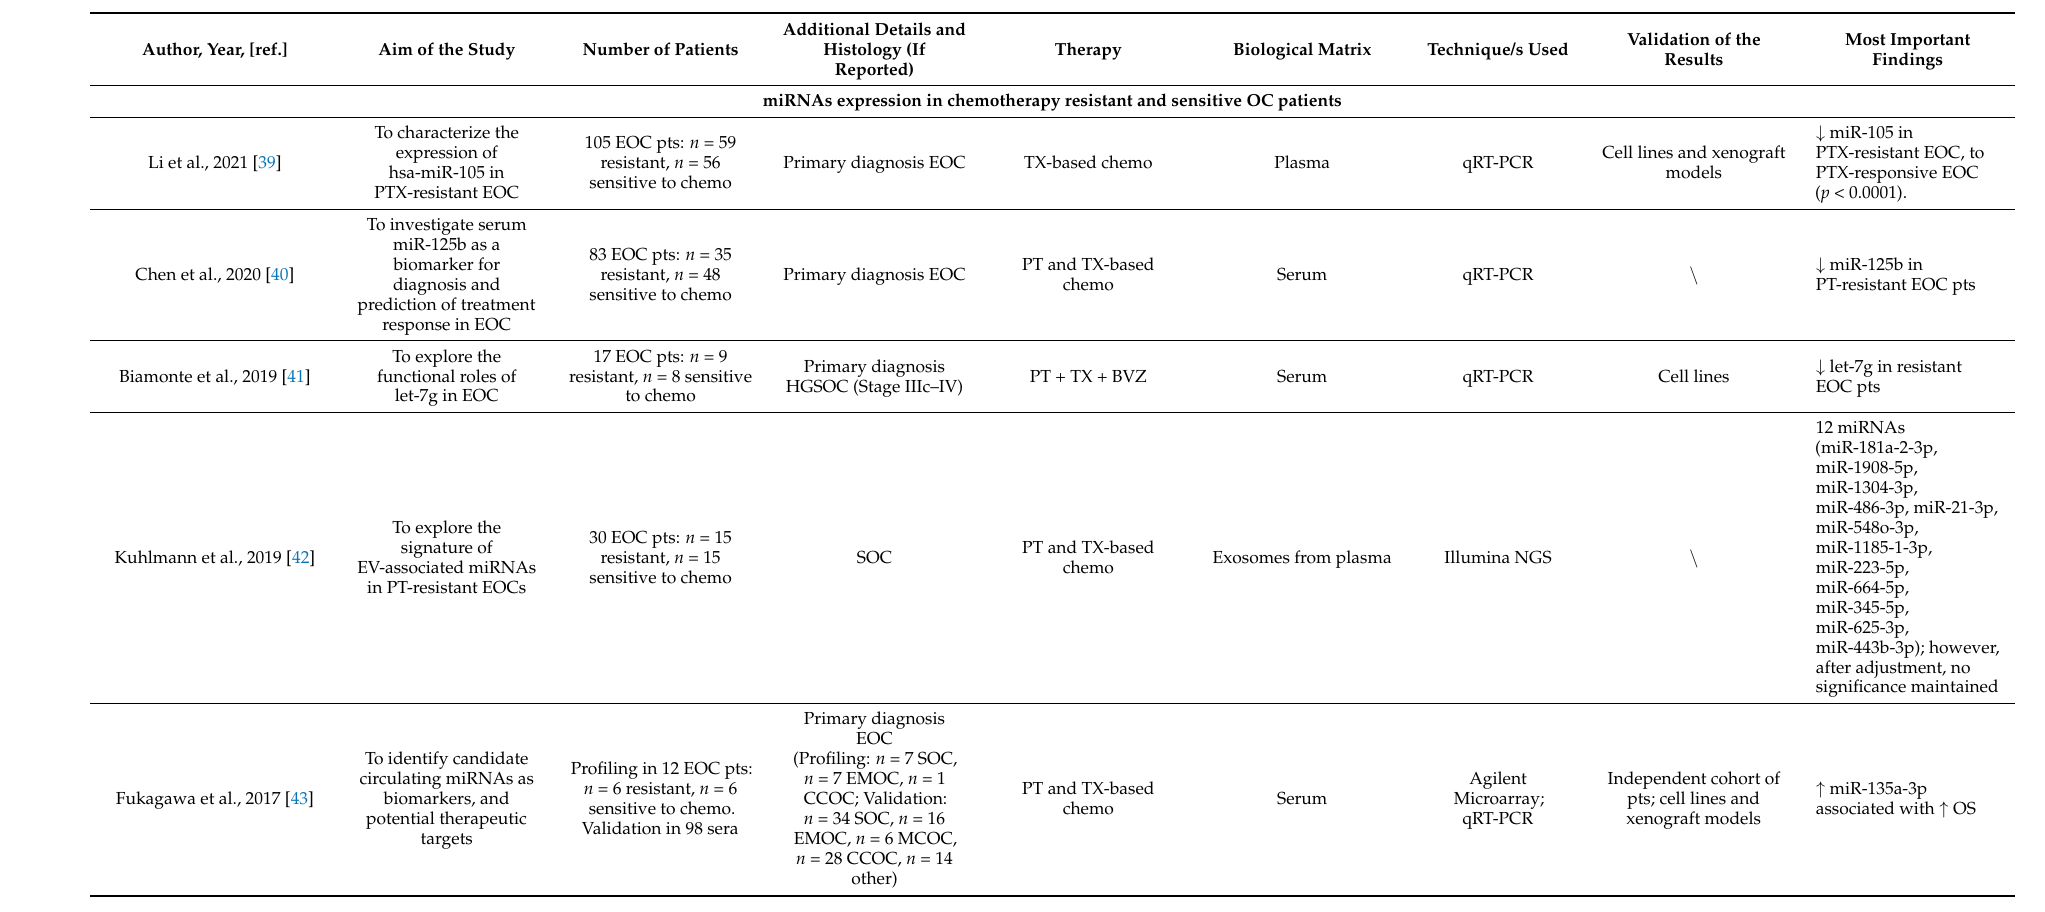
Table 1. Studies included in the systematic